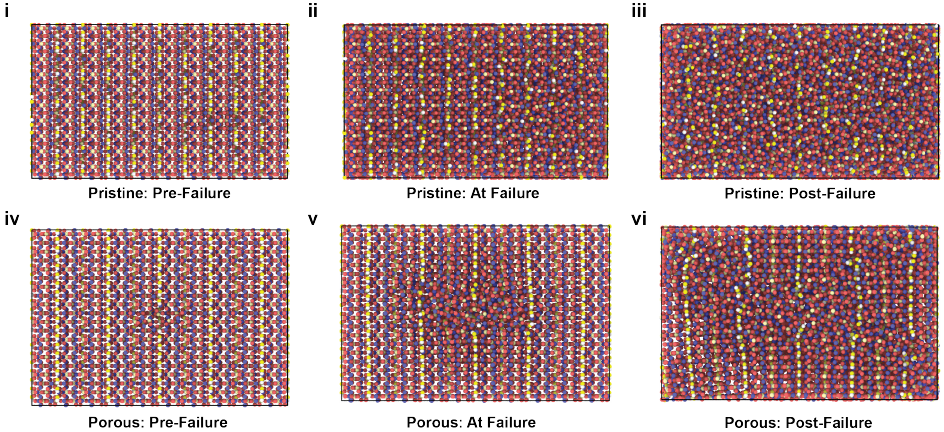
Figure 6. Atomic snapshots of the pristine HAP model ( i – iii ) and of the HAP model having a 7.5 Å pore ( iv – vi ) at various time-steps, i.e., before failure, at the inception of failure, and after failure under compressive loading in the Z direction. The view is in the Y-Z